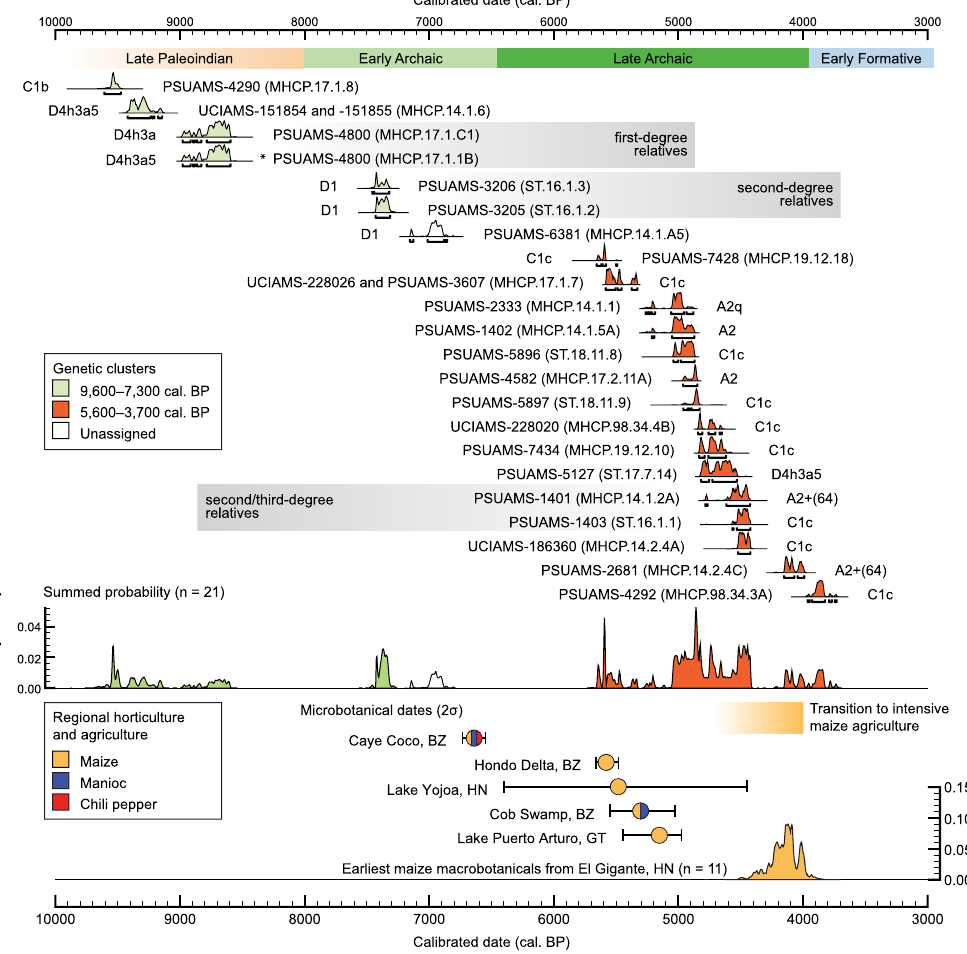
Fig. 3 Radiocarbon dates and evidence for farming in the Maya region. Top: dates of individuals with genetic data (individual 95.4% con fi dence intervals and total summed probability density; MHCP.19.12.17 [low-coverage] omitted for scale). *Date based on association with familial relative. Bottom: earliest radiocarbon dates associated with microbotanical evidence for maize, manioc, and chili peppers in the Maya region and adjacent areas at Lake Puerto Arturo, Guatemala (GT) 26 ; Cob Swamp, Belize (BZ) 24 ; Rio Hondo Delta 25 ; Caye Coco, BZ 23 ; and Lake Yojoa, Honduras (HN) 27 , together with summed probability distribution of the earliest maize cobs ( n = 11) in southeastern Mesoamerica from El Gigante rock-shelter, HN 28 . Also shown in yellow is the known transition to staple maize agriculture based on dietary stable isotope dietary data from MHCP and ST 8